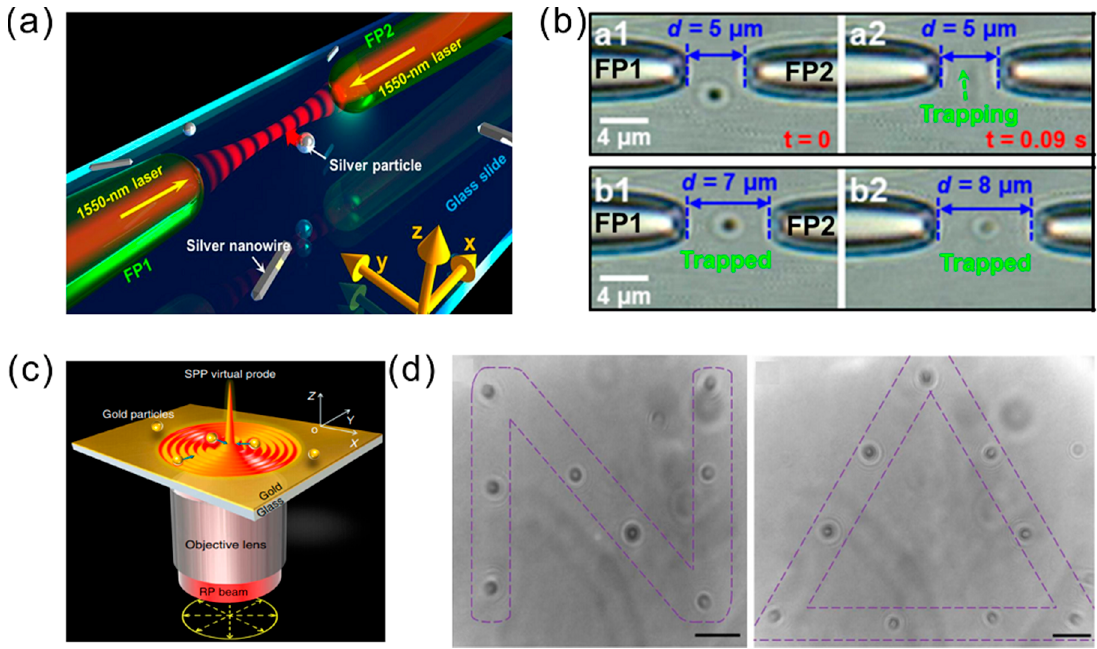
Figure 4. ( a ) Schematic for three-dimensional (3D) optical trapping silver nanostructures. ( b ) Optical trapping images obtained using a tip-to-tip fiber couple. Adapted from [35], with permission from © 2016 Springer Nature. ( c ) Schematic of trapping metallic particles by an surface plasmon–polariton (SPP) virtual probe. ( d ) Patterns constructed by Au NPs in the focused plasmonic tweezers. Adapted from [36], with permission from © 2013 Springer Nature.